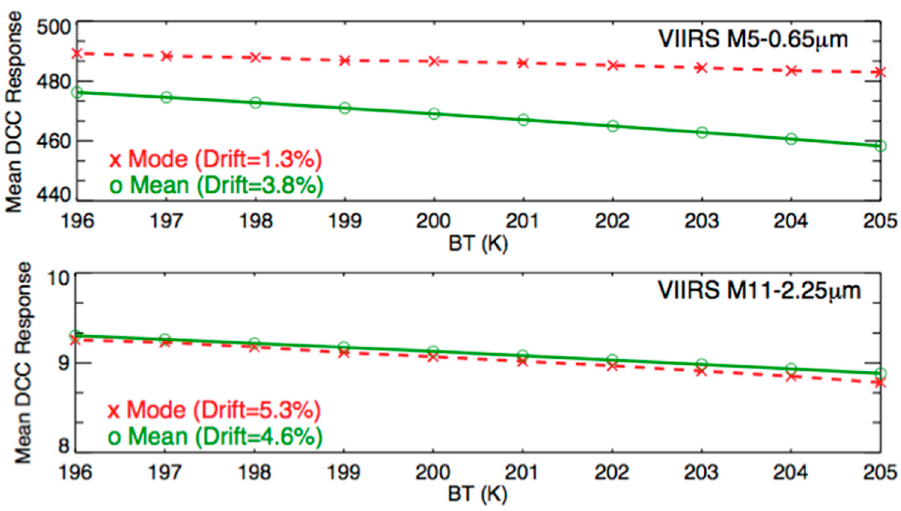
Figure 7. The VIIRS M5 (0.65 µm) ( top panel ); and M11 (2.25 µm) ( bottom panel ) DCC normalized radiance as a function of BT (11 µm) threshold. The drift is the change in DCC radiance in percent between 196 K and 205 K. The dashed and solid lines shown above simply connect the adjacent data points.